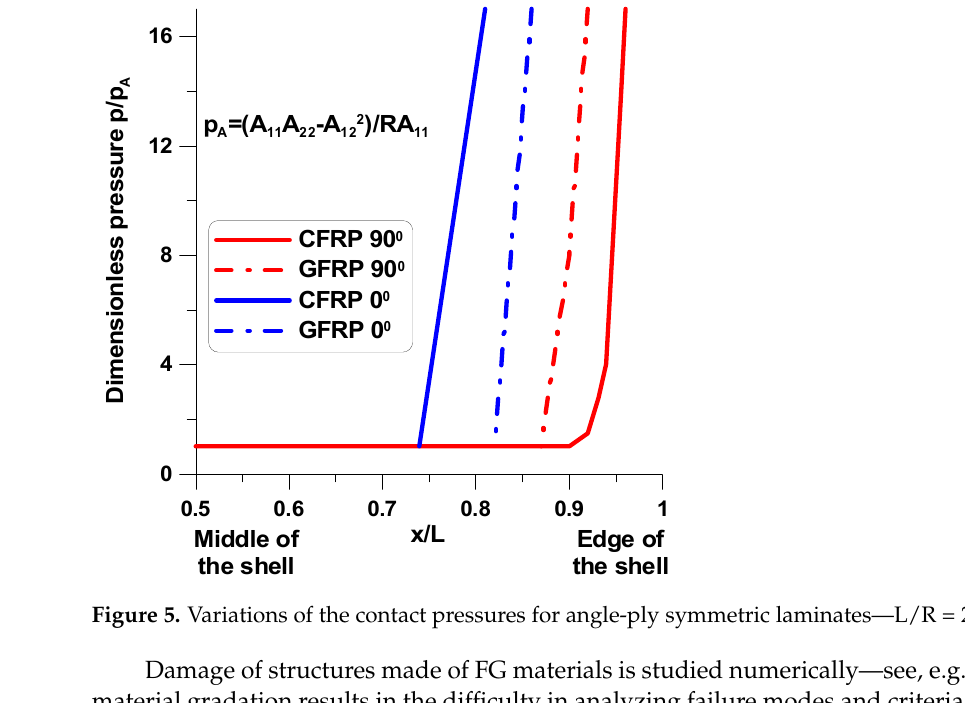
7 of 10 Comparing these results with the normal radial displacements (Equation (16) and Figure 4), it is seen that the higher stiffness D 11 results in the increase of the contact pressures. Table 1. Mechanical properties of laminates.